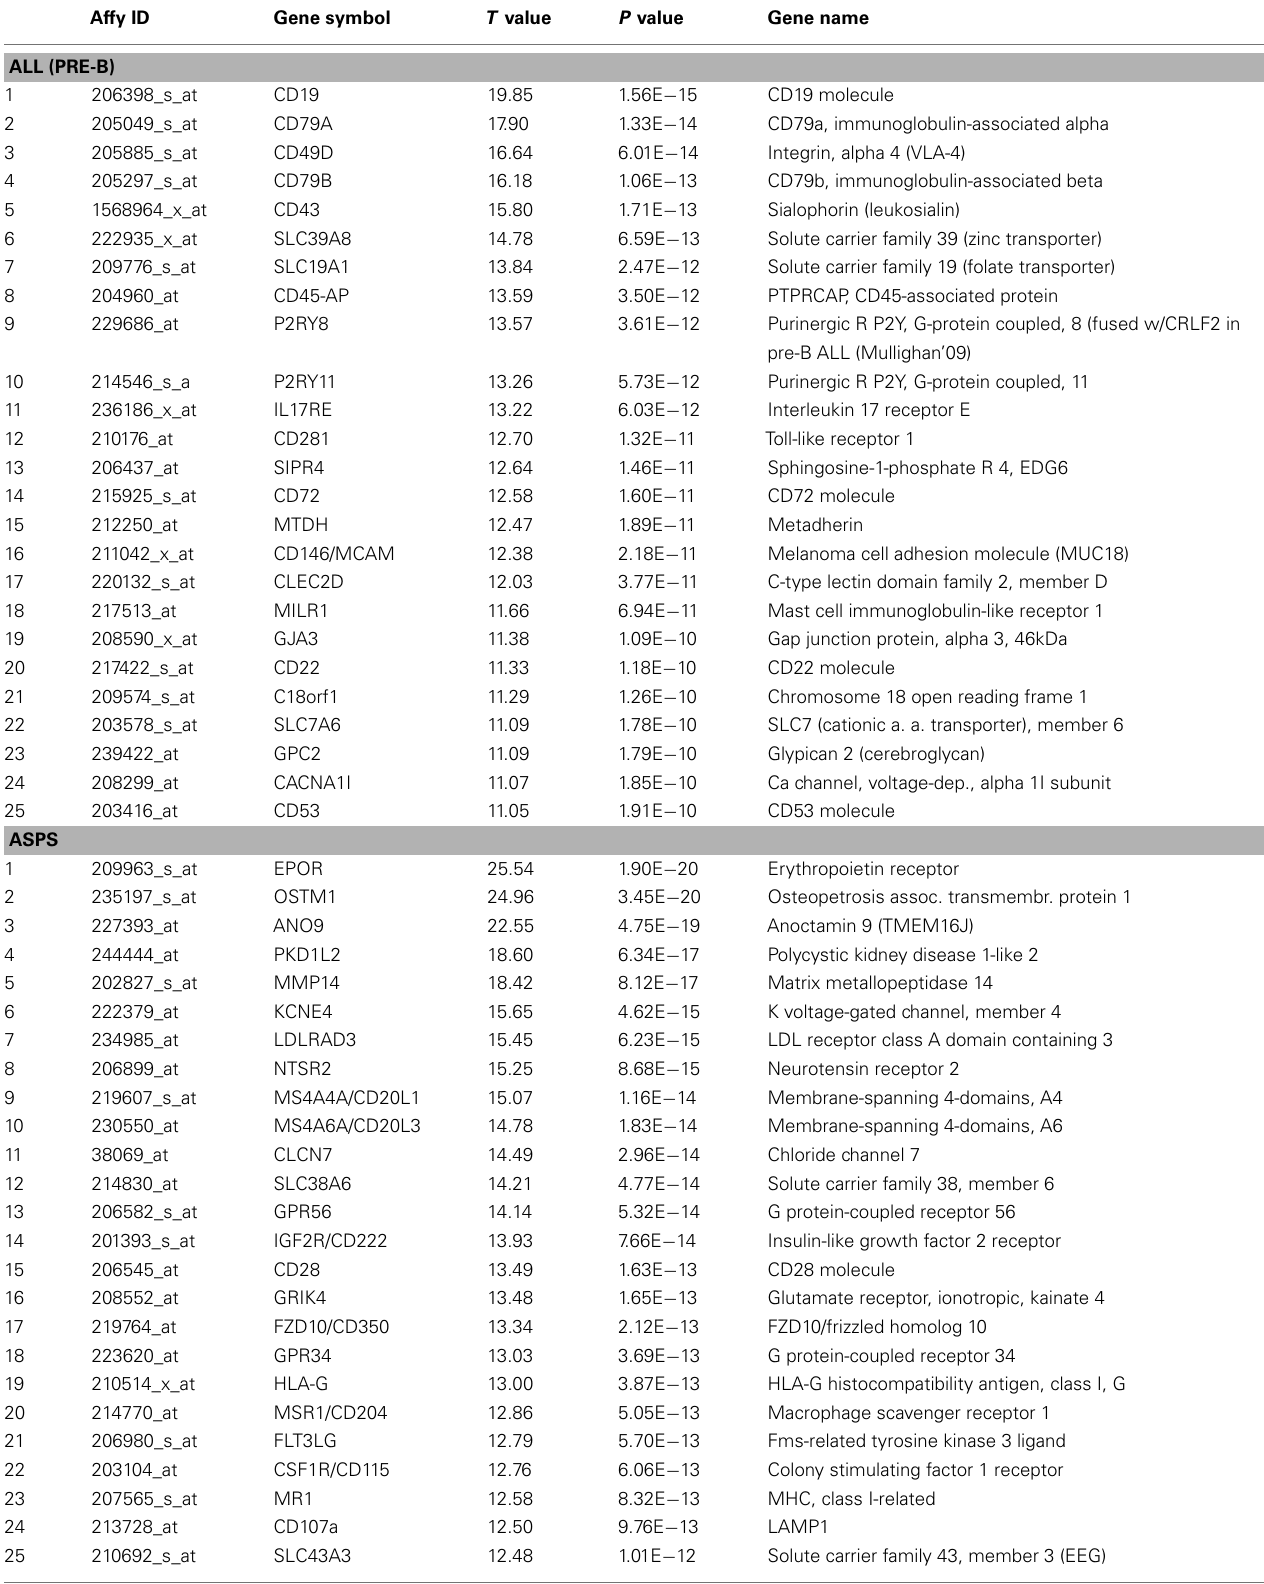
Table 3 | Pediatric tumor antigens arranged by functional